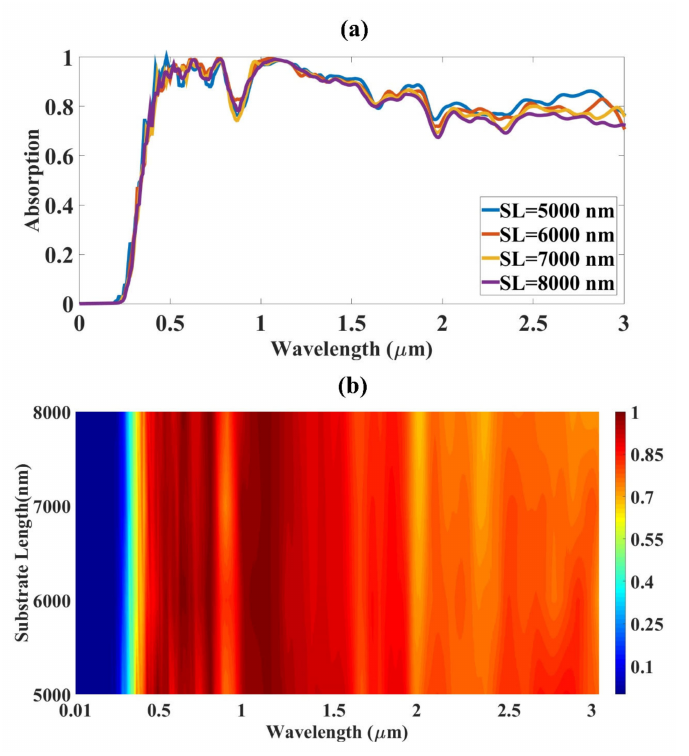
Figure 5. Absorption response for variation in SL (substrate length). The variation is carried out from 5000 to 8000 nm with a separation of 1000 nm. The absorption spectrum is presented in the form of ( a ) line, ( b ) color plots for 0 to 3000 nm.